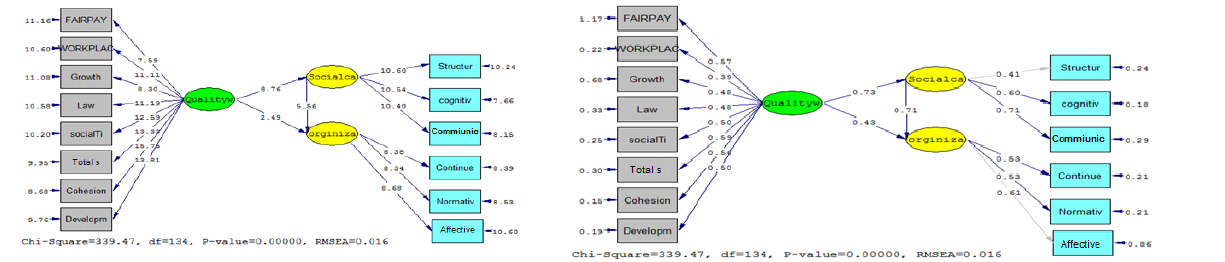
Fig. 2. The results of final model confirmation of relationship between work life quality, social capital and organizational commitment